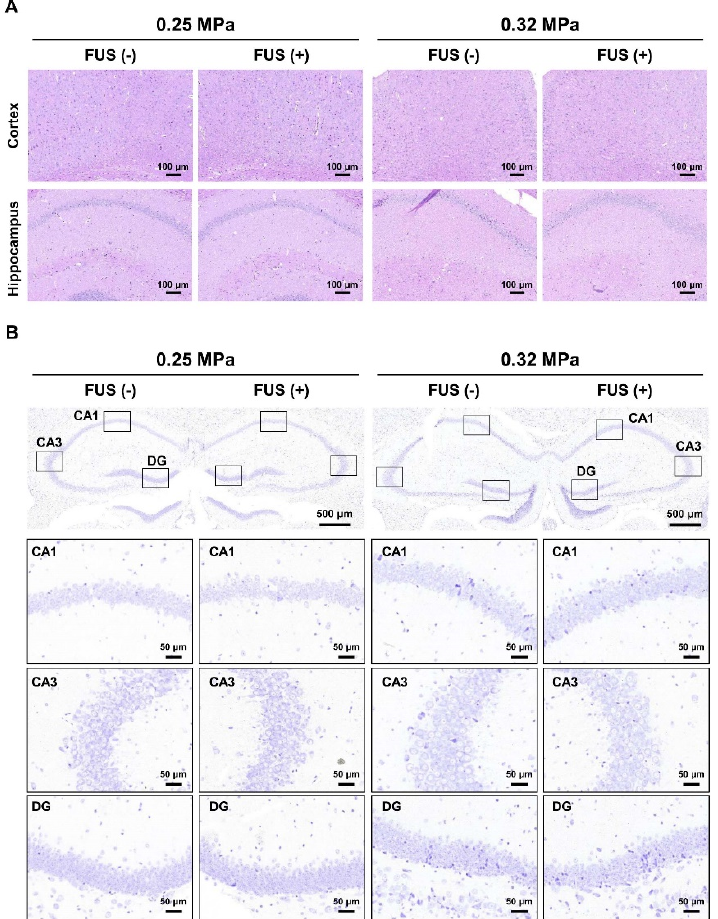
Figure 7. Histopathological evaluation of the brain tissue of APP/PS1 mice subjected to FUS-BBBD. ( A ) Representative H&E-stained images showed the cortex (top) and hippocampal (bottom) regions after 0.25 MPa FUS (two columns on the left) and 0.32 MPa FUS (two columns on the right). Scale bars represent 100 µ m ( B ) Representative images of the CA1, CA3, and DG hippocampal regions stained using cresyl violet 5 days post-BBBD. Scale bars represent 500 µ m for images of the hippocampus region ( B , upper) and 50 µ m for enlarged images ( B ,